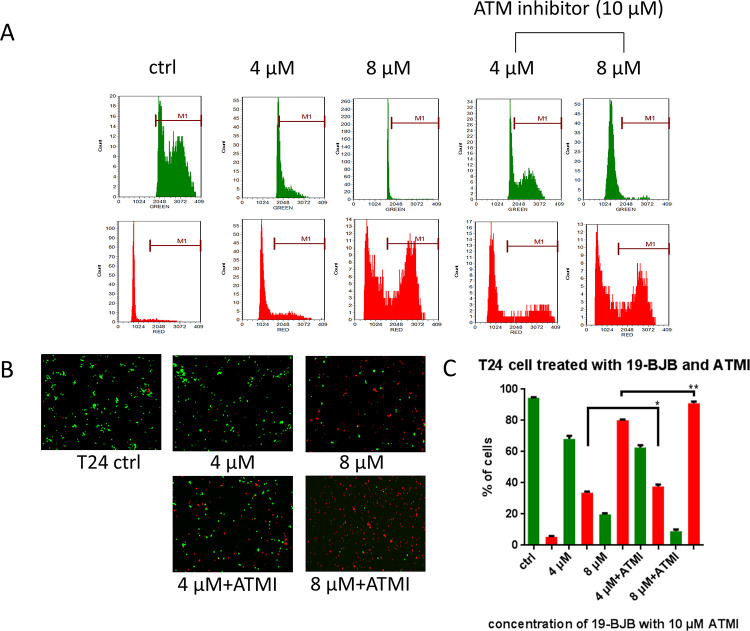
The results of live and dead test of cells affected by 19-BJB and ATMI, detected by TailTM Image-Based Cytometer.Green column represented the number of live cells and red column represented the number of dead cells. Photos of T24 live cells were stained green by 4 μM calcein AM and dead cells were stained red by 2 μM ethidium homodimer. The raw data of fluorescence response were showed (A). Cells were treated by two ways, one for treated with 19-BJB for 48 h (0, 4, 8 μM), the other treated with 10 μM ATMI first, then 19-BJB for 48 h (4, 8 μM). The histogram data (C) are expressed as means ± SD from triplicate samples for each treatment. ****p < 0.0001.